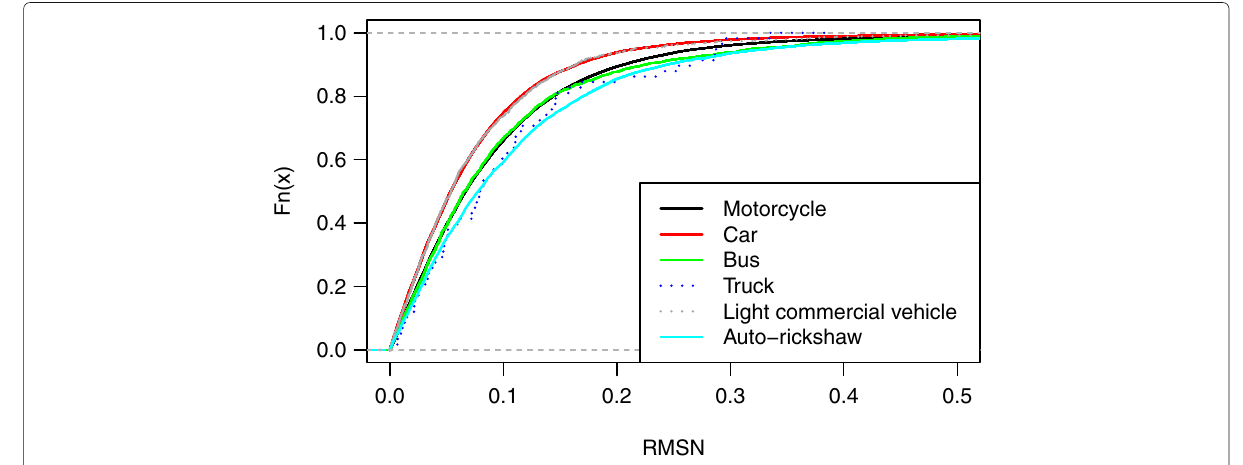
Fig. 7 ECDF of RMSN per vehicle type for dataset “data300”